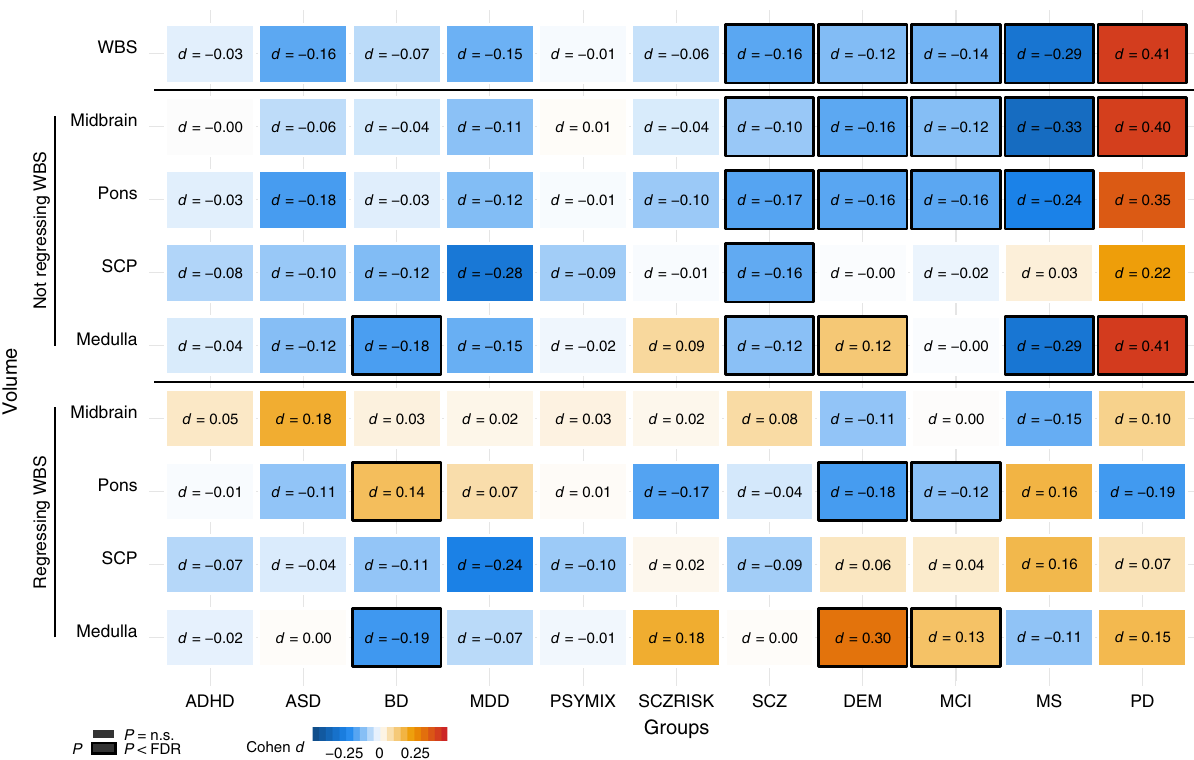
Fig. 5 Volumes of brainstem structures in individuals with common brain disorders compared with healthy controls. Linear models were run covarying for sex, age, age², intracranial volume, and scanner site. The analyses for volumes of midbrain, pons, SCP, and medulla oblongata were run both with and without covarying for whole brainstem volume. The fi gure depicts the resulting case-control differences in Cohen ’ s d, whereas group differences in mm 3 are presented in Supplementary Fig. 14. There were differential volumetric alterations in individuals with BD, SCZ, DEM, MCI, MS, and PD as indicated by black frames, after controlling for multiple testing using false discovery rate (Benjamini – Hochberg, accounting for all 99 tests). ADHD attention-de fi cit/ hyperactivity disorder. ASD autism spectrum disorders. BD bipolar disorder. MDD major depressive disorder. PSYMIX non-SCZ psychosis spectrum diagnoses. SCZRISK prodromal SCZ or at risk mental state. SCZ schizophrenia. DEM dementia. MCI mild cognitive impairment. MS multiple sclerosis.